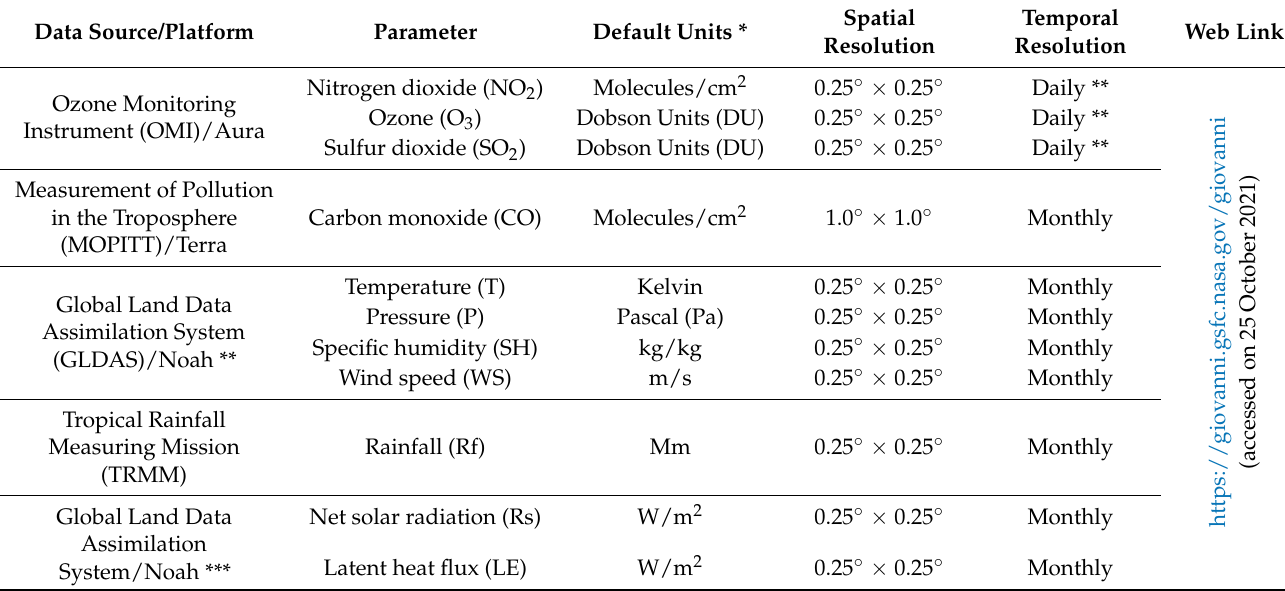
Table 1. Key specifications of the data utilized in this